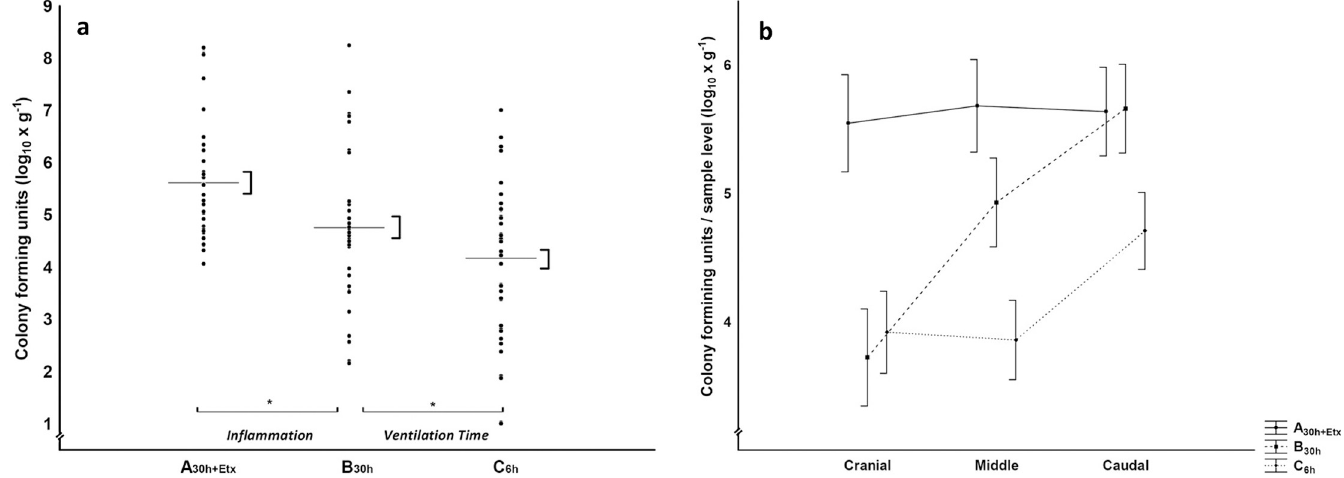
Fig 2. Bacterial growth in lung tissue. P . aeruginosa counts, log 10 colony forming units per gram lung tissue. a) Dots represent raw data for each group, mean ± SEM (line, brackets), general linear model, � denotes p < 0.05, experimental parts Inflammation A 30h+Etx vs. B 30h , Ventilation Time B 30h vs. C 6h . b) Descriptive graphical presentation of distribution based on sample level (cranial, middle, caudal) for each group connected by a line, brackets SEM for each level.